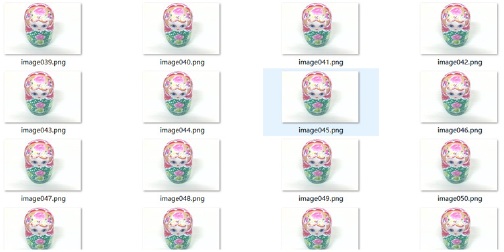
Figure 12. Identify the training process.